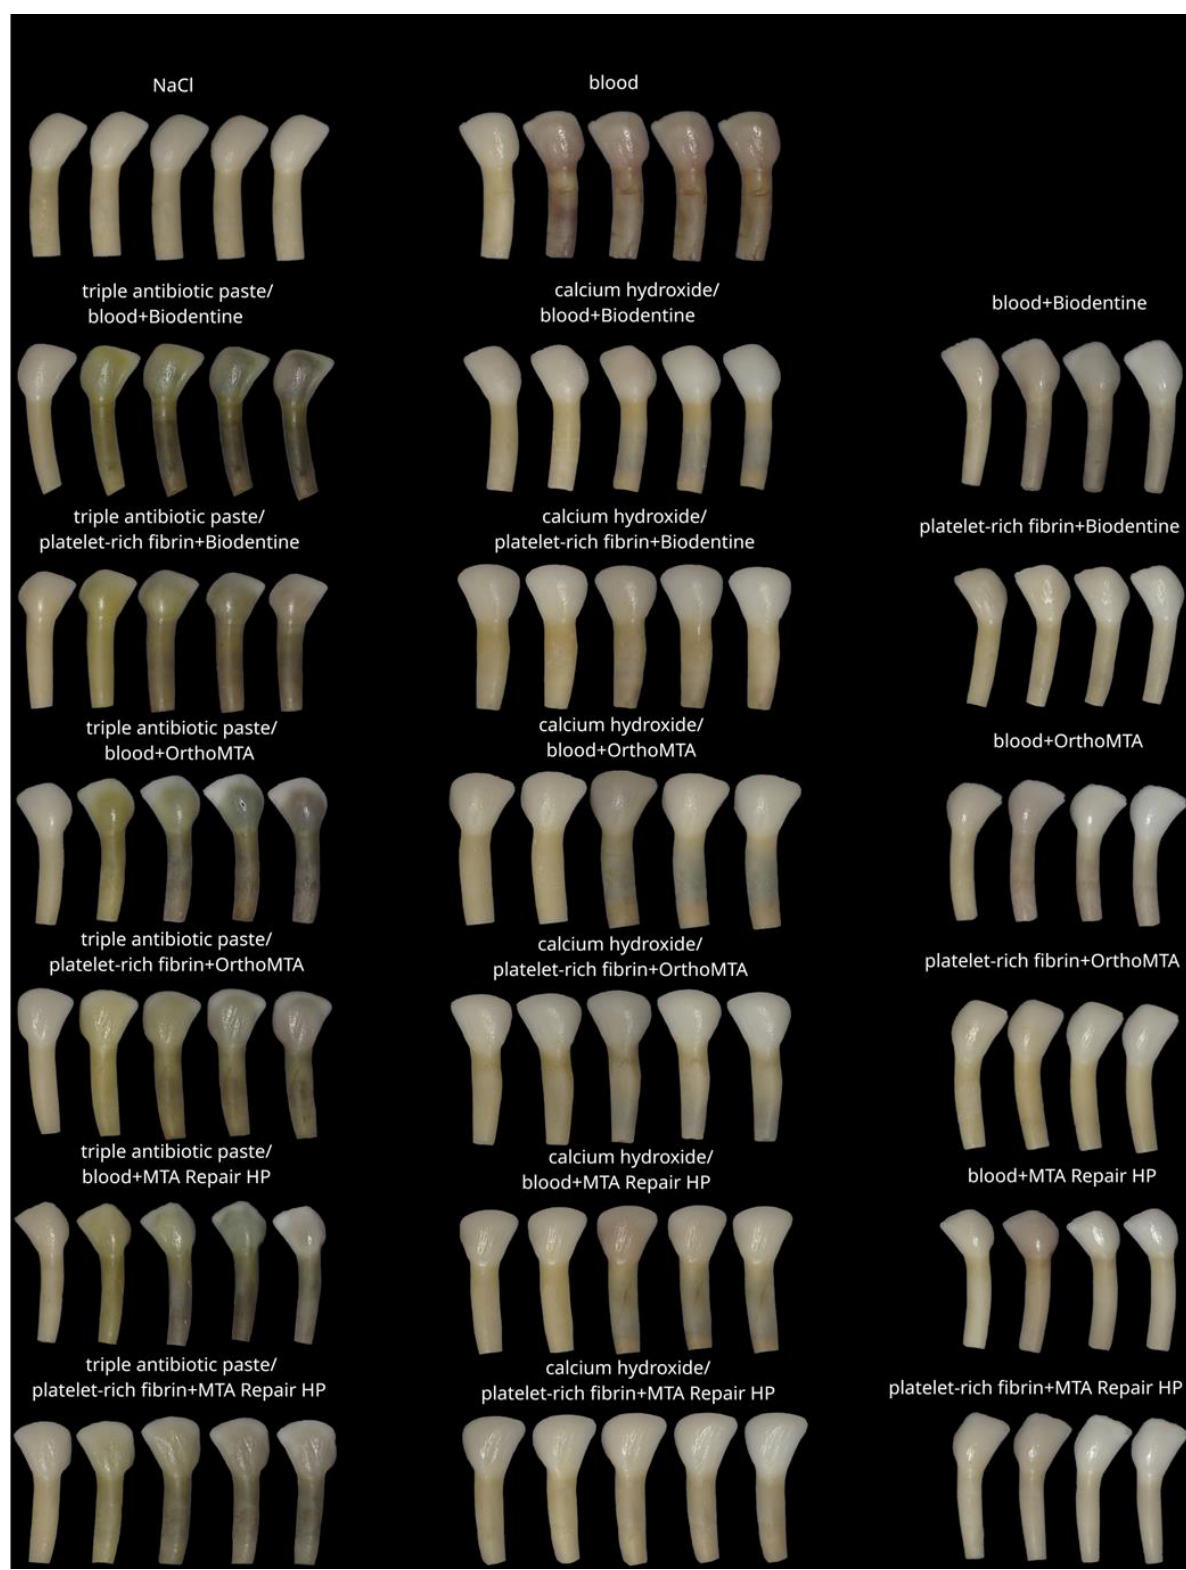
Figure 9. Representative images of the experimental groups. Left, the first tooth after step 0; right, the steps increase to step 4.